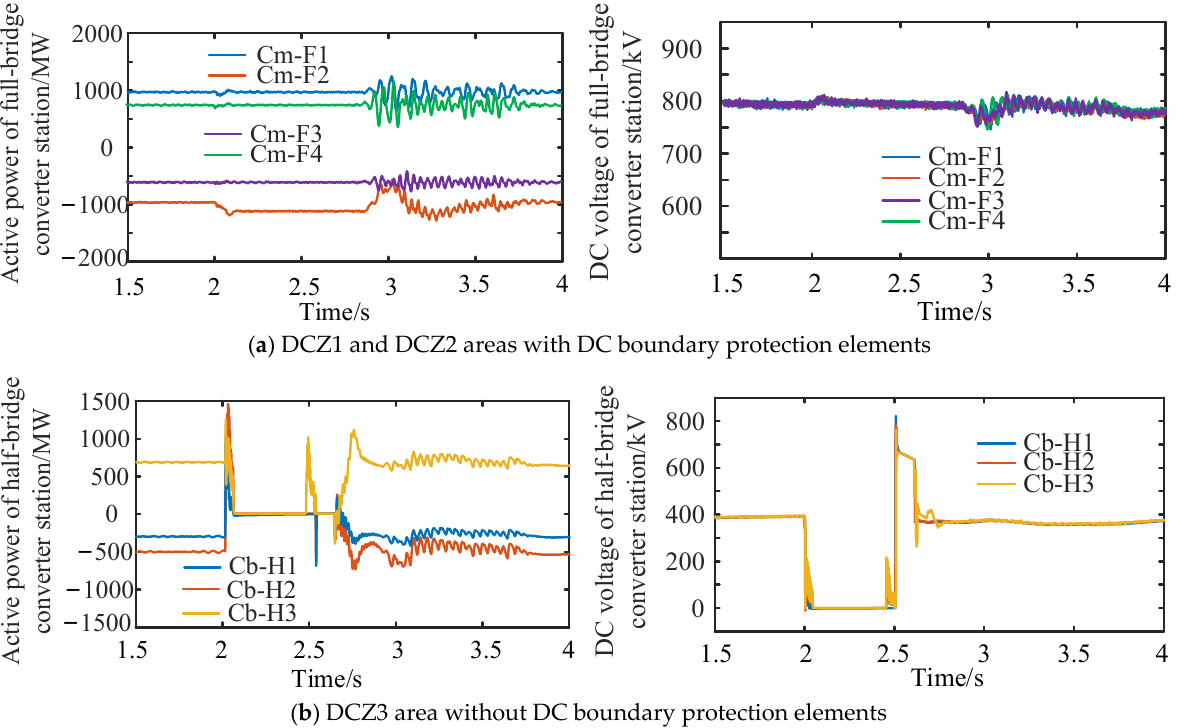
Figure 20. Protection boundary elements and fast switch action signal in DCZ 3. In the process of fault isolation and reclosure, the active power and DC voltage at the outlet of each converter station in DC regions DCZ1, DCZ2 and DCZ3 are shown in Figure 21. When the fault occurs at 2 s, the active power and DC voltage of all converter stations in DCZ1 and DCZ2 fluctuated slightly and recovered to stability after about 0.1 s. The active power of Cm ‐ F1, Cm ‐ F3 and Cm ‐ F4 remains basically unchanged, while the ab ‐ sorbed active power of Cm ‐ F2 increases from 970 MW to 1120 MW; the active power and DC voltage of the converter station in DCZ3 of the DC region fluctuated sharply and then decreased to 0 after about 0.05 s, at which time the AC circuit breaker was completely disconnected. work fluctuate. Moreover, the fluctuation amplitude of Cm ‐ F2 in the converter station is relatively large, and the maximum active power fluctuation amplitude is about 50%. The system returns to stable operation after about 1 s.